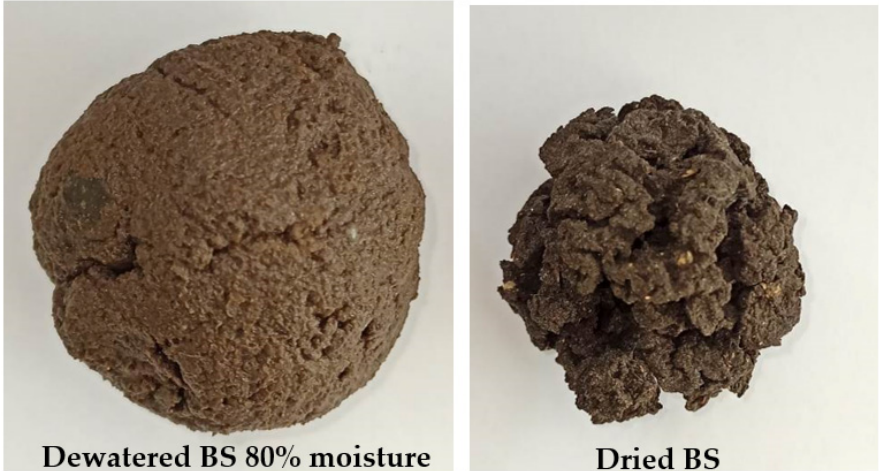
Figure 2. Anaerobically digested biosolid morphological changes (shrinkage, cracking, skin layer formation) during drying. Convective drying at 138 °C and drying gas velocity of 2 m/s.